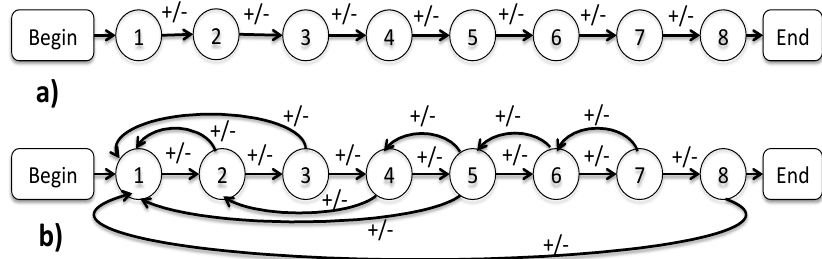
Figure 14. Automata describing ( a ) Optimistic personality ( b ) Obsessional